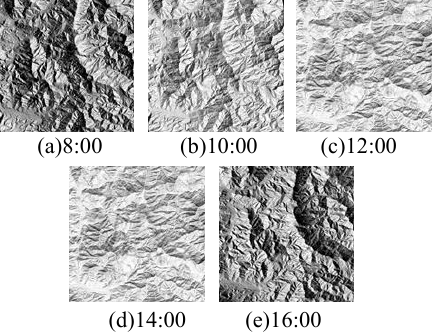
Figure 7. DEM simulated terrain shading images under illumination conditions of different time on a day.